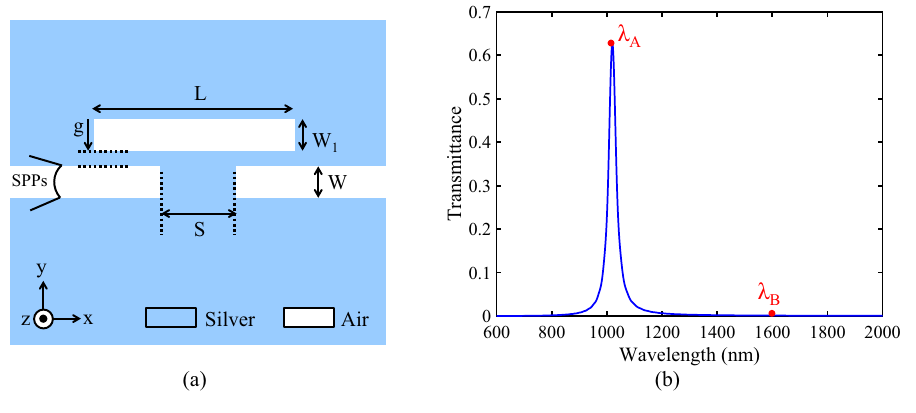
Figure 1. (a) Schematic of the basic filter. (b) Its transmission